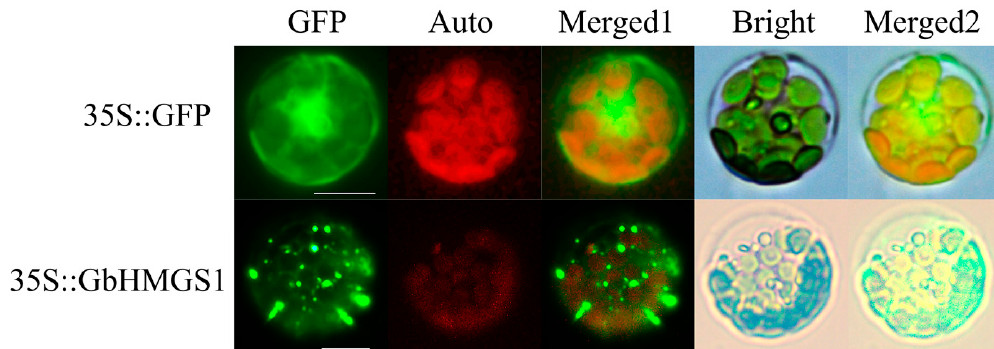
Figure 4. Subcellular localization of GbHMGS1. GFP: green fluorescent protein; Auto: chlorophyll autofluorescence; Merged1: fusion of both types of fluorescence; Bright: bright field; Merged2: fusion of Merged1 and Bright. The scale bar represents 10 μ m.